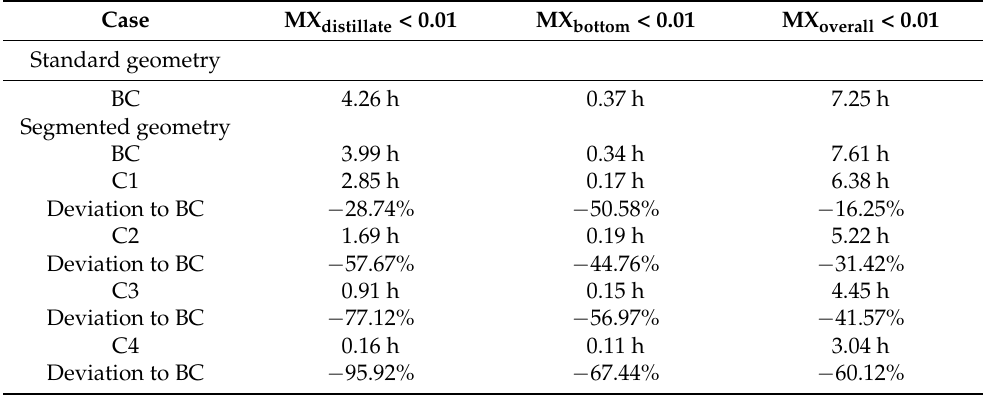
Table 2. Start-up time results for the case